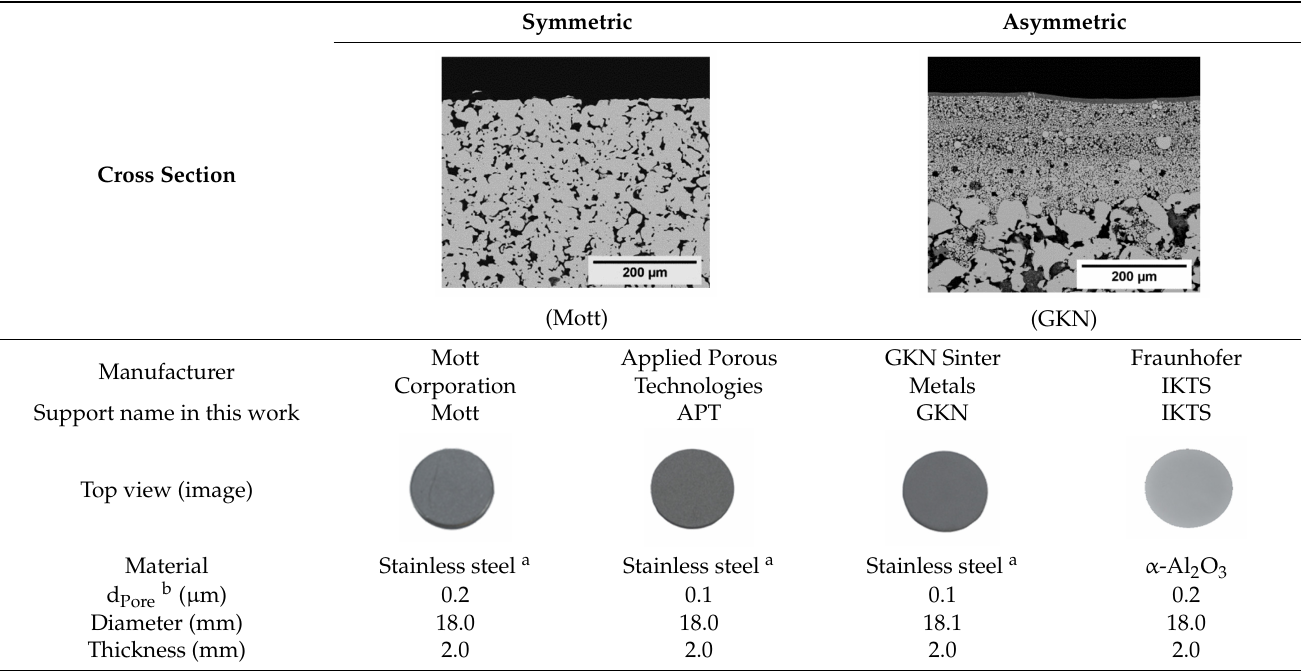
Table 1. Overview on the membrane supports and their specifications used in this work.